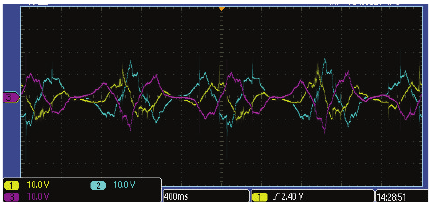
Figure 5: The measured no-load voltage of wave energy extraction